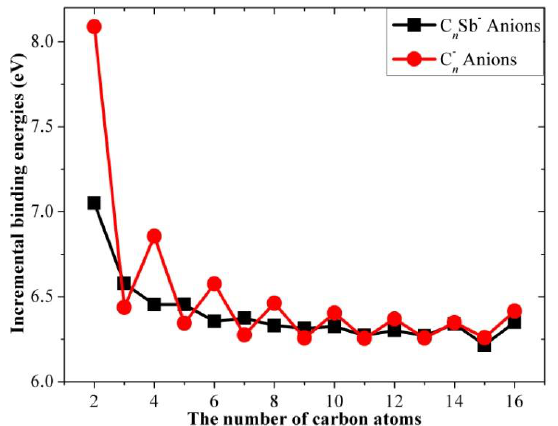
− anions and pure C n Sb